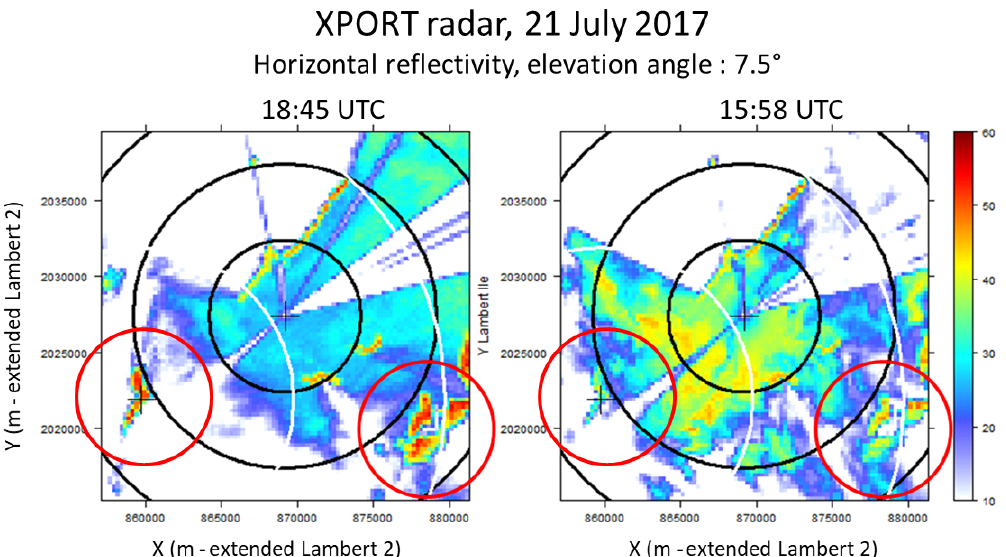
Figure 3. Examples of XPORT 7.5 ◦ PPIs of raw reflectivity (not corrected for attenuation) taken for two time steps during the 21 July 2017 convective event. The crosses indicate the location of the two radars and the black/white (5/10km) range markers correspond to the XPORT and the MOUC radar, respectively. The red circles highlight the mountain returns associated with the Chamrousse (southeast) and the Moucherotte (southwest) mountains in between the 10–15km